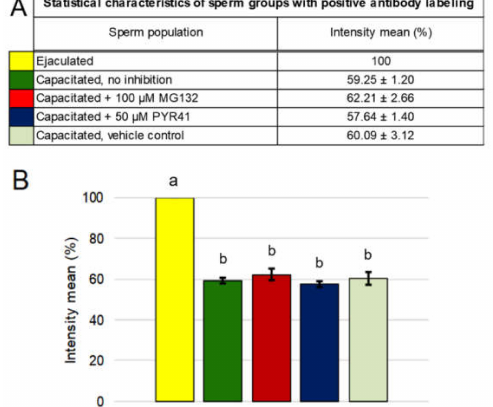
Figure 3. Quantification of the MSMB removal during in vitro capacitation (IVC). The baseline fluorescent intensity mean of ejaculated spermatozoa was defined as 100%, to which the other IVC sperm groups were compared. ( A ) The decrease in fluorescent intensity mean in IVC spermatozoa treatment groups, i.e., non-inhibited, proteasomally-inhibited, E1-inhibited, and vehicle control. ( B ) Graphic representation of fluorescent intensity means in all treatment groups. Results are presented as the mean ± SD of four independent biological replicates. Statistical significance ( p < 0.05) is indicated by